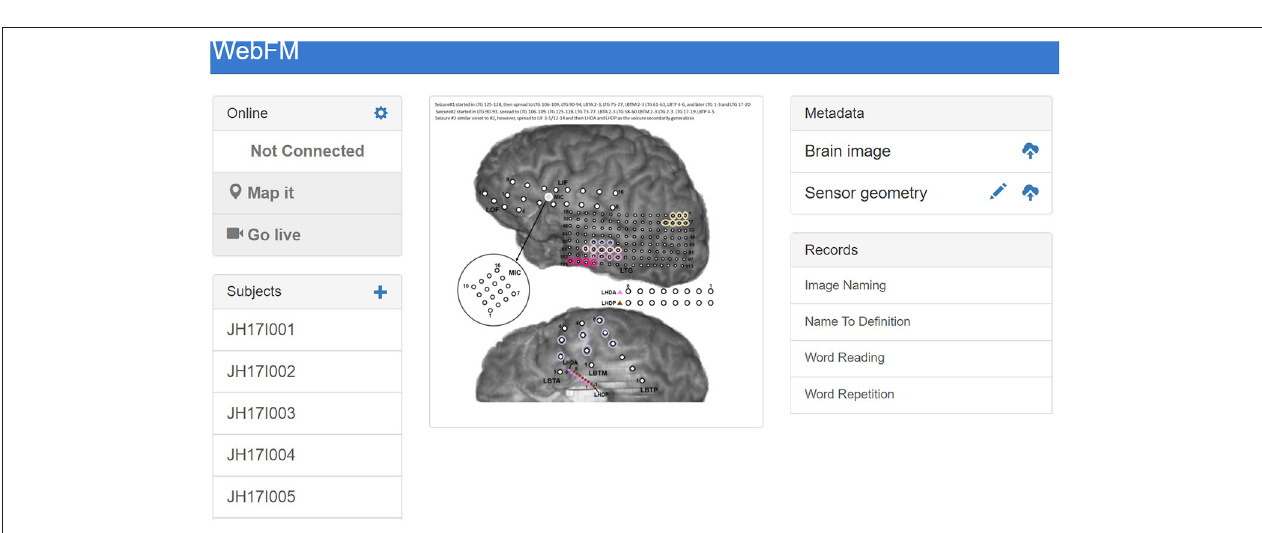
FIGURE 3 | The landing page for WebFM. A pane in the top left shows system state and houses buttons that start trial-based functional mapping paradigms and a “live” mode that visualizes neural activity on the brain in real-time, as visualized in prior studies ( Lachaux et al., 2007). A list of subject identifiers on the bottom left pane enables users to pull up previous/current subjects; a list of saved maps for the selected subject appears in the “Records” pane on the bottom right. The “+” in the top left of the “Subjects” pane allows operators to add new subjects to the database, and the “Metadata” pane at the top right allows operators to upload brain reconstruction images and normalized electrode locations for displaying functional mapping results. The brain images used for mapping are often overlaid with information about seizures and/or ESM results, so that functional activation can be easily visually compared with these data; the image shown in the center includes colored circles depicting the hypothesized spread of ictal activity during the subject’s